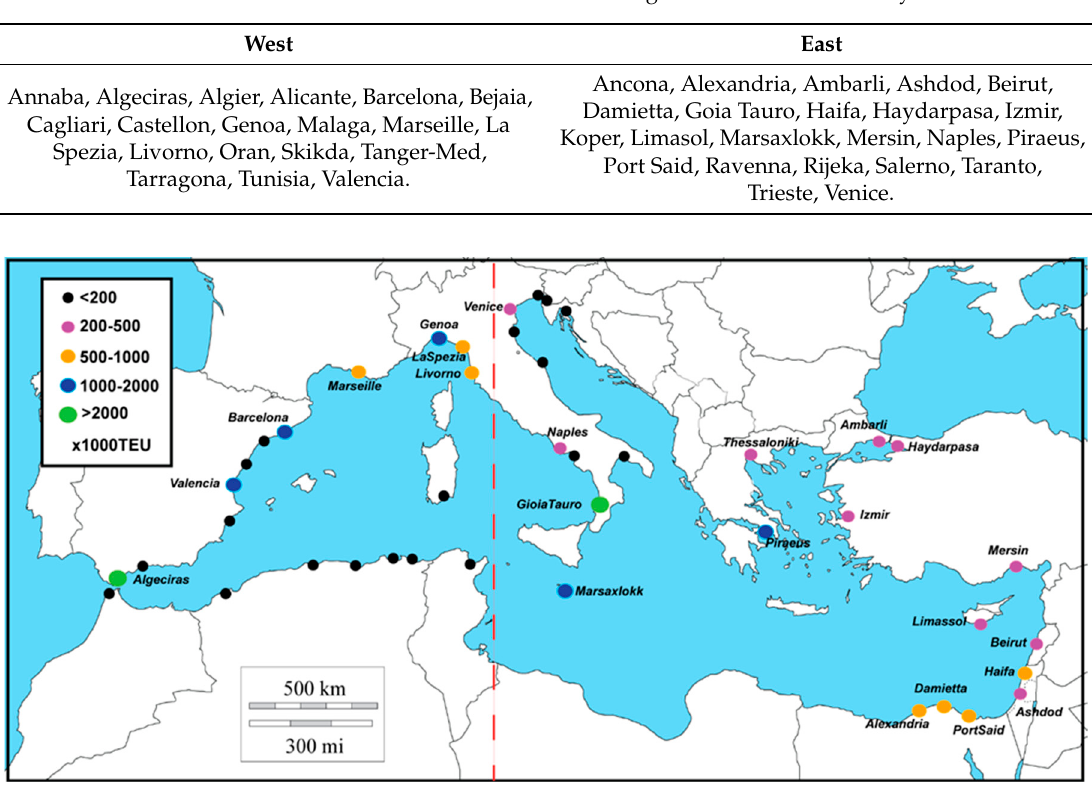
Figure 1. Container throughput in the main Mediterranean Ports for 2000 (in × 1000 TEU). The red dashed lines show the division used in the analysis. For clarity, only the names of the ports with > 200,000 TEU appear on the map.